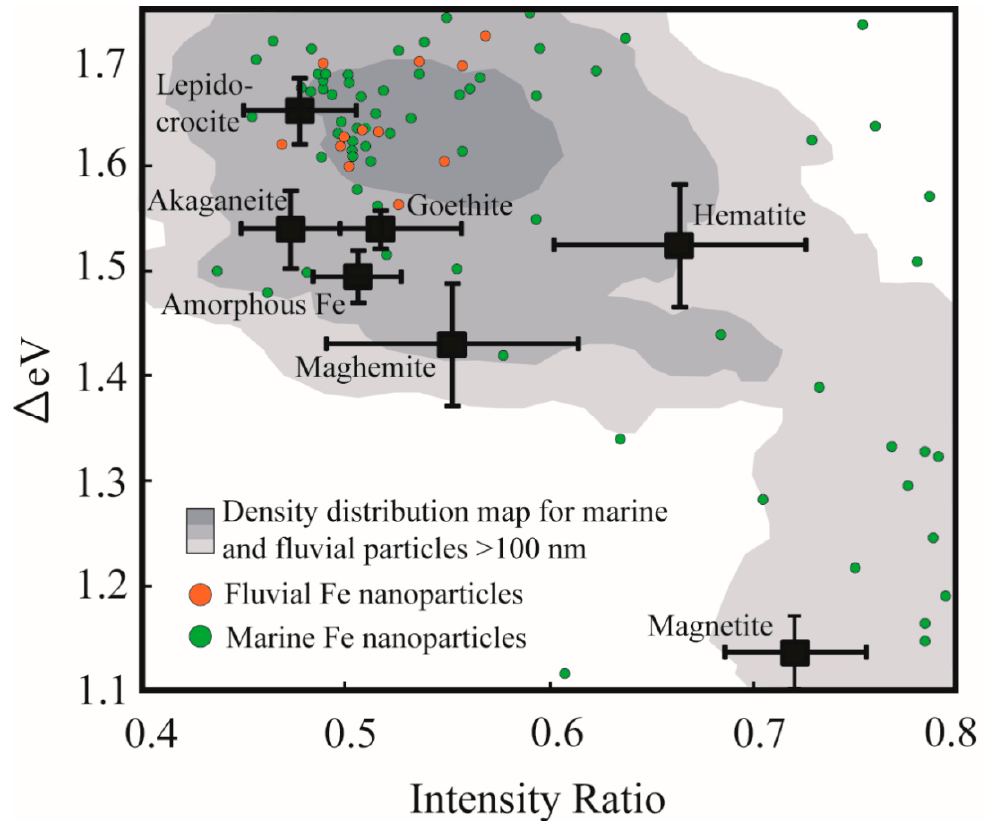
Figure 2. Plot of the spectral parameters ∆ eV versus intensity ratio clearly illustrating the discrete fields occupied by synthetic Fe mineral standards (black squares and associated bars representing standard deviation (modified after Reference [15])). Colored point data represent the spectral signatures for individual Fe nanoparticles from fluvial (orange) and marine (green) systems, whereas the shaded region represents the density distribution of data points for sub-micrometer (larger than 100 nm) and micrometer sized particles collected from marine and fluvial environments (generated using ArcGIS point density function).